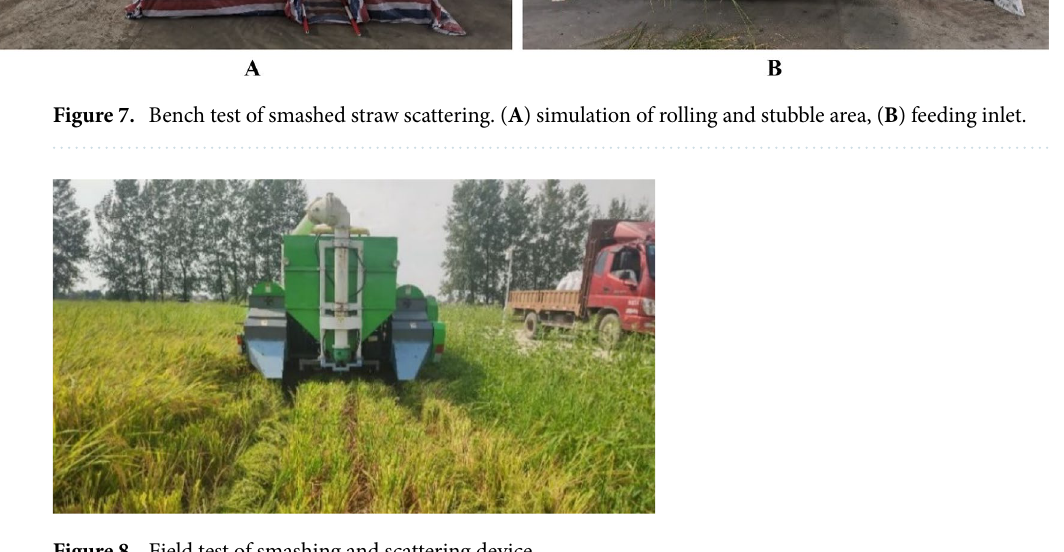
Figure 8. Field test of smashing and scattering